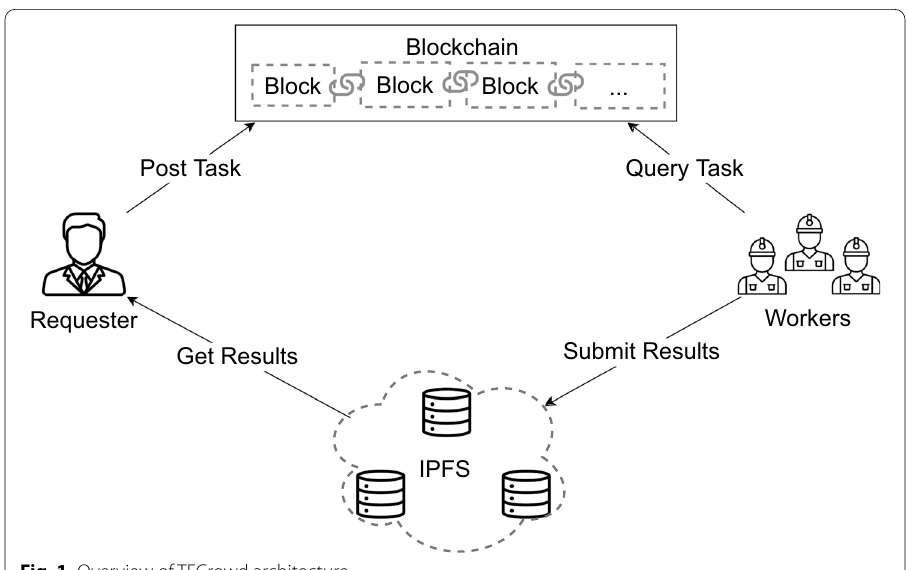
Fig. 1 Overview of TFCrowd